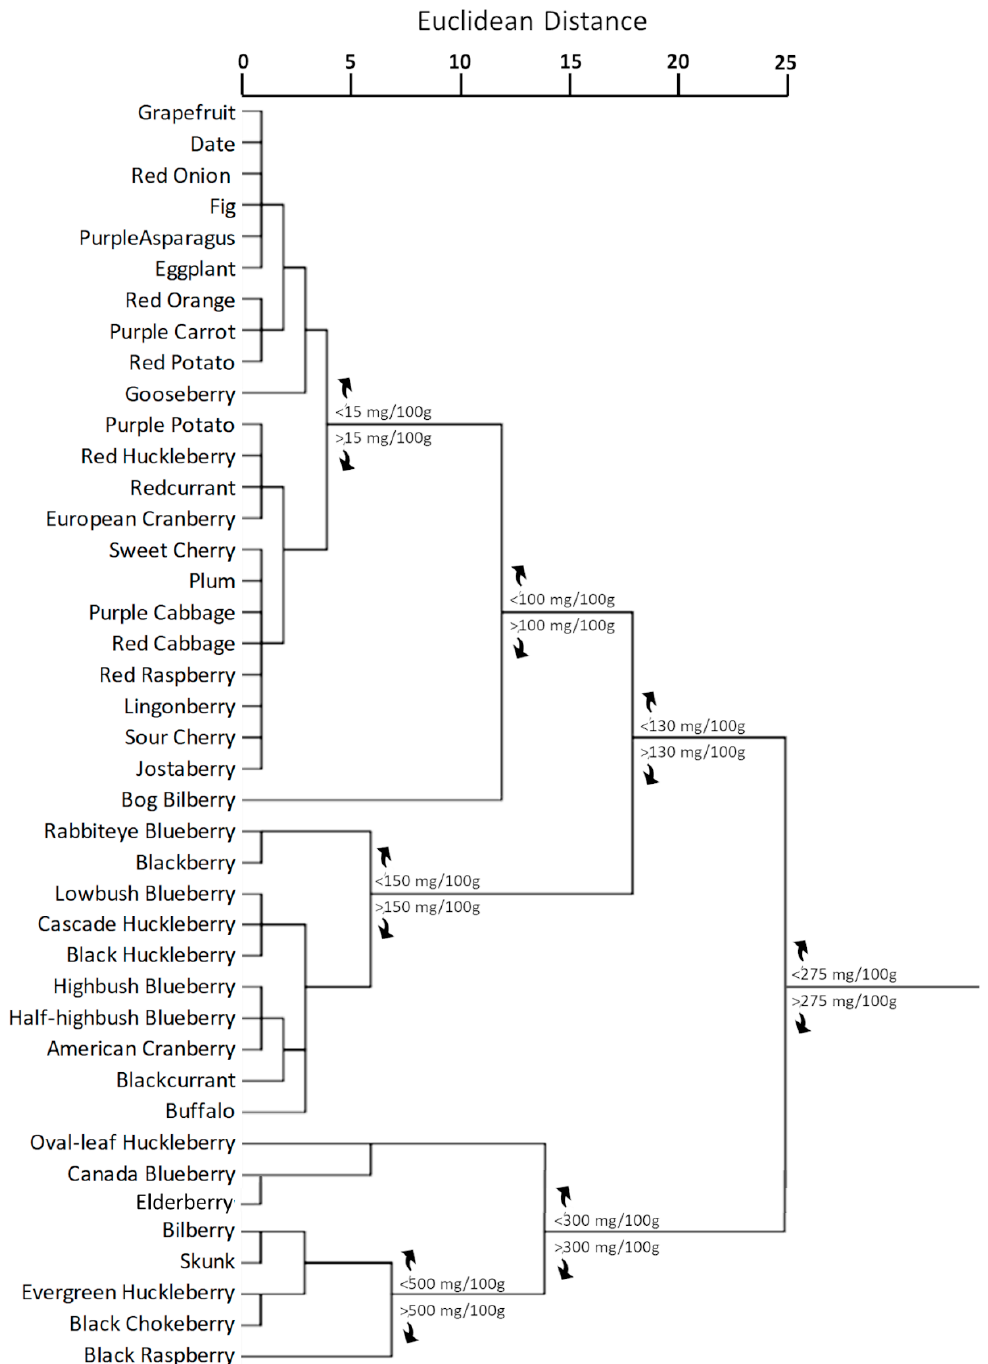
Figure 4. Cluster distribution of anthocyanins in plant kingdom based on the total anthocyanin content according to Phenol-Explorer Database [184–186]. Euclidean distances were calculated with average linkage method. Statistical analysis and graphical representation were made using SPSS v. 24 software. The cluster was generated by using SPSS ver.24 statistical software.